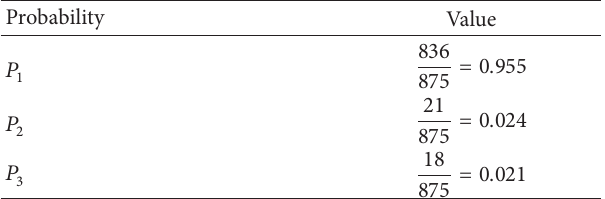
Table 3: Channel states